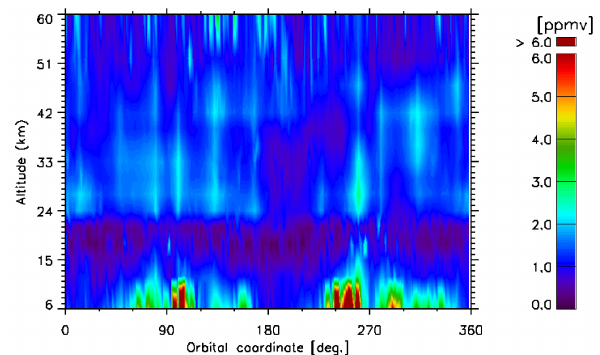
Figure 4. 2-D distribution of the averaged absolute difference be- tween reference and retrieved CO 2 VMRs resulting from the sample test (see